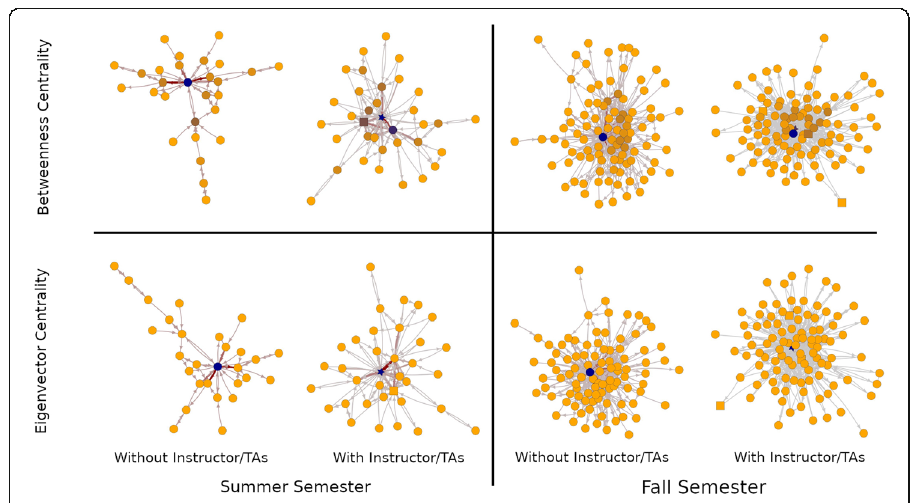
Fig. 1 Change of centrality between with and without